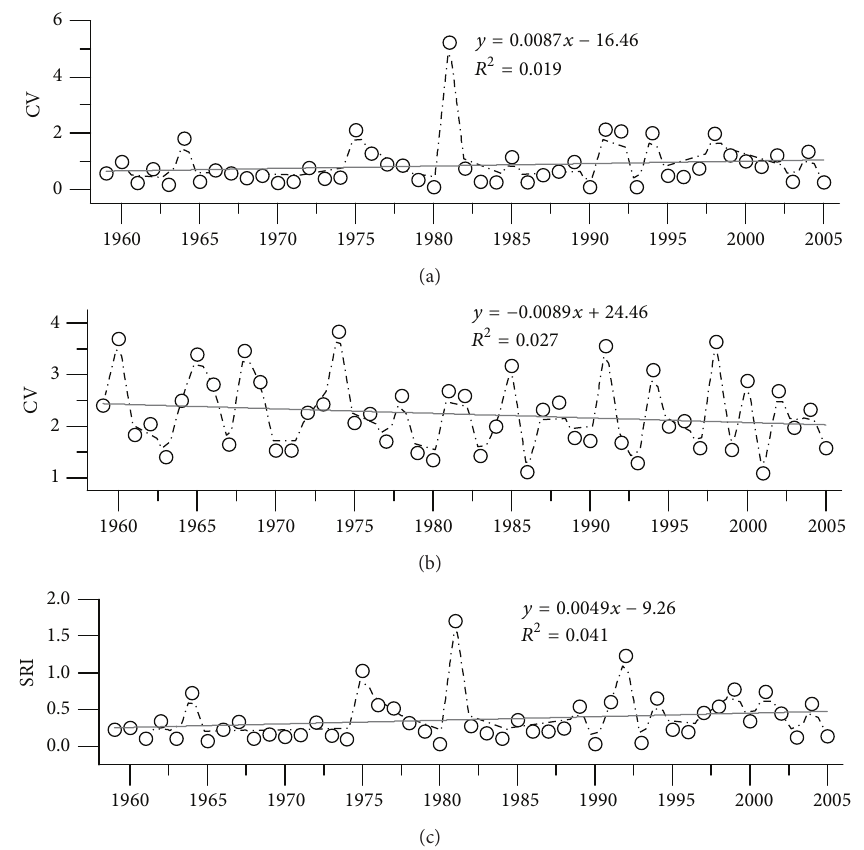
Figure 7: Variation coefficient of runoff, rainfall, and SRI in Caizuizi Station: (a) runoff, (b) rainfall, (c) SRI.